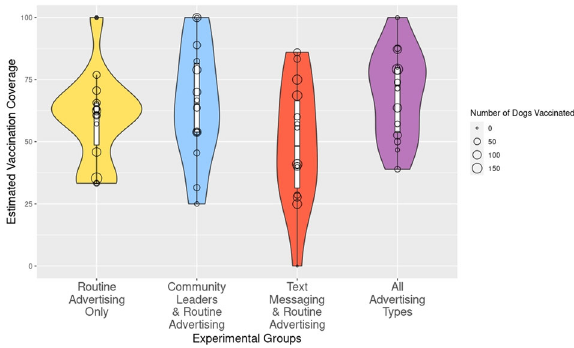
Fig. 2 Mean vaccination coverage estimated from post-vaccination transects, variation for all four experimental groups and numbers of dogs vaccinated in each study village. Villages that received both interventions had the highest mean vaccination coverage, at ~70%, whereas the group receiving text messaging had the lowest at around 50%. Average vaccination coverage in the group with only routine advertising and the group with routine advertising plus community leaders was 60% and 65%,